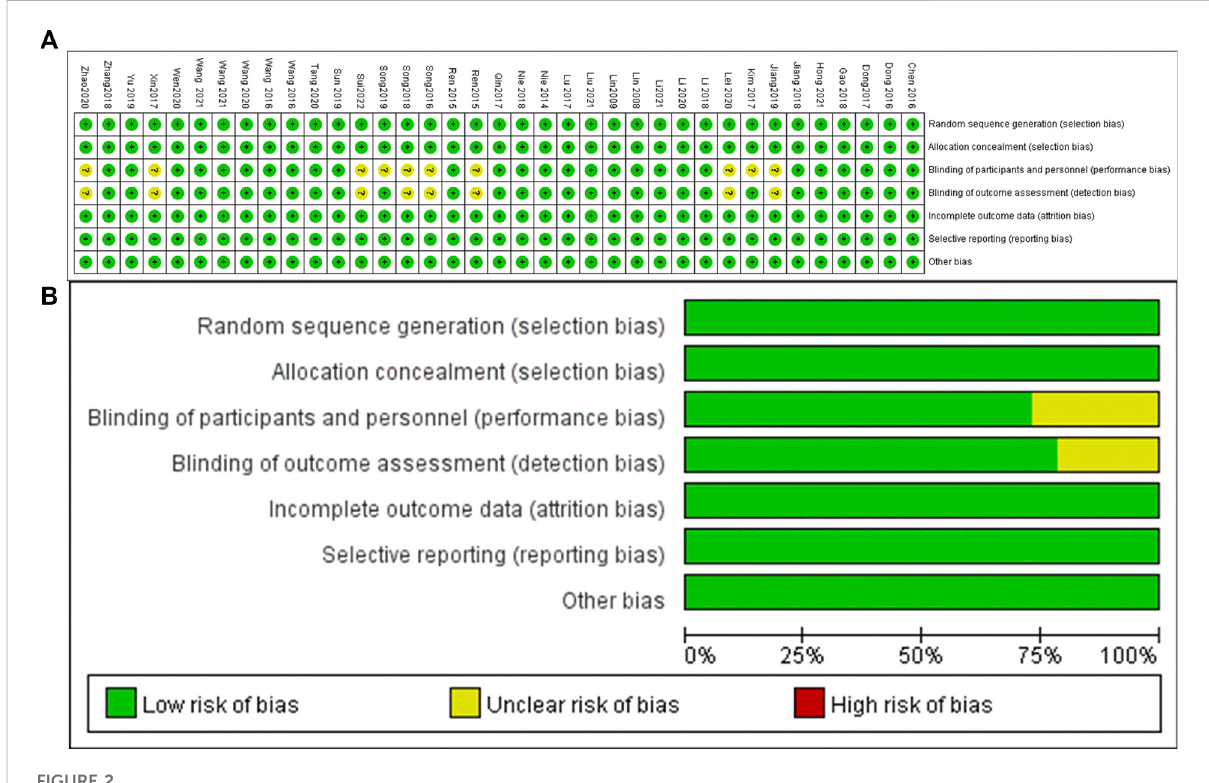
FIGURE 2 Theriskofbiasassessmentoftheincludedstudies. (A) Riskbiasofsummary, (B) Riskbiasofgraph.Note:Therewerenohighriskofbiasfoundin these